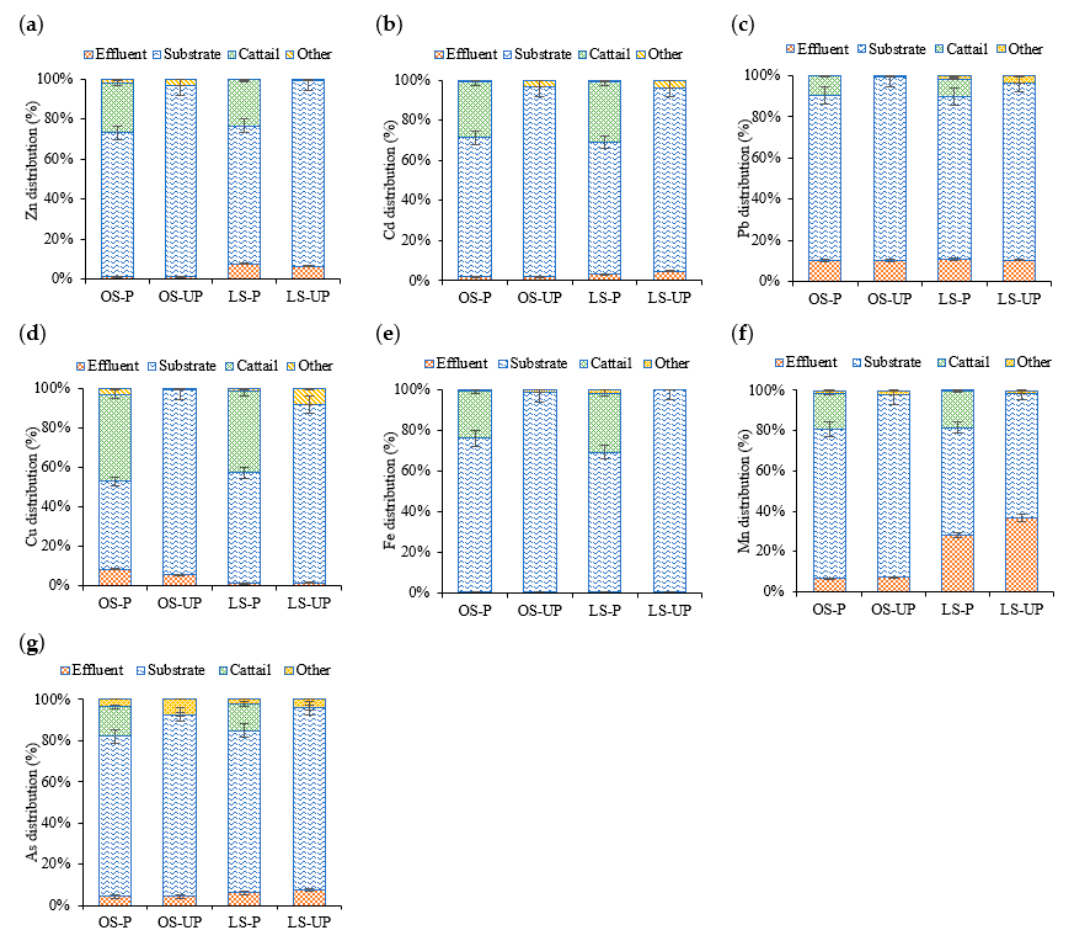
Figure 6. Heavy metal removal pathways in oyster shell (OS)/limestone (LS)-based planted (P)/unplanted (UP) CWs during 7-month AMD treatment: Zn ( a ), Cd ( b ), Pb ( c ), Cu ( d ), Fe ( e ), Mn ( f ), and As ( g ).